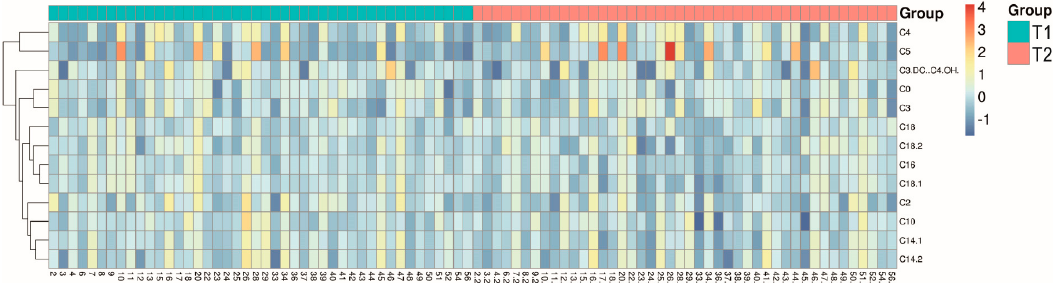
Figure 1. Hierarchical cluster analysis giving an overview of differences in metabolites between T1 and T2.